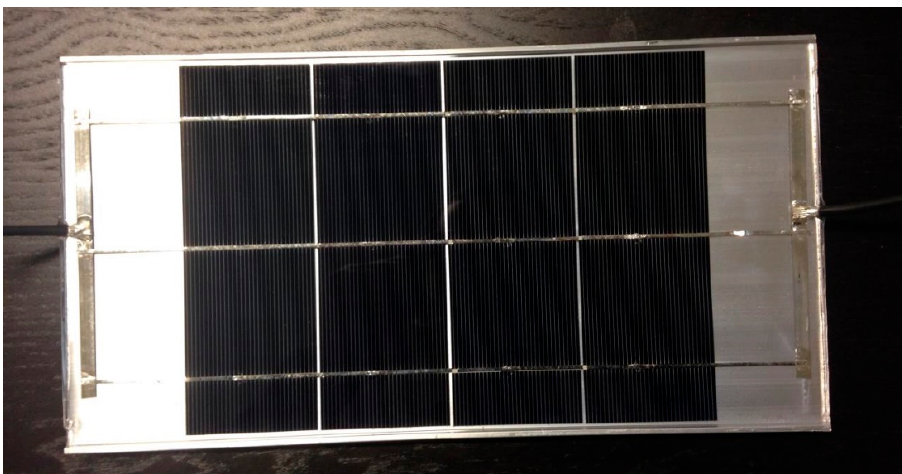
Figure A8. Receiver 8 has four 1/3 cells with a standard cell gap, one point soldering, transparent silicon only and no strain relief.